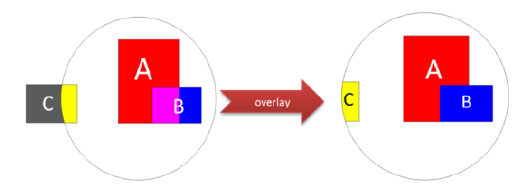
Figure 8. Overlaying the polygons with the perspective circle and together